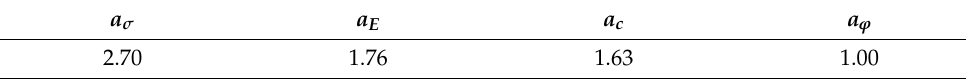
Table 2. Similarity constants of the argillaceous calcareous siltstone to rock-like material.